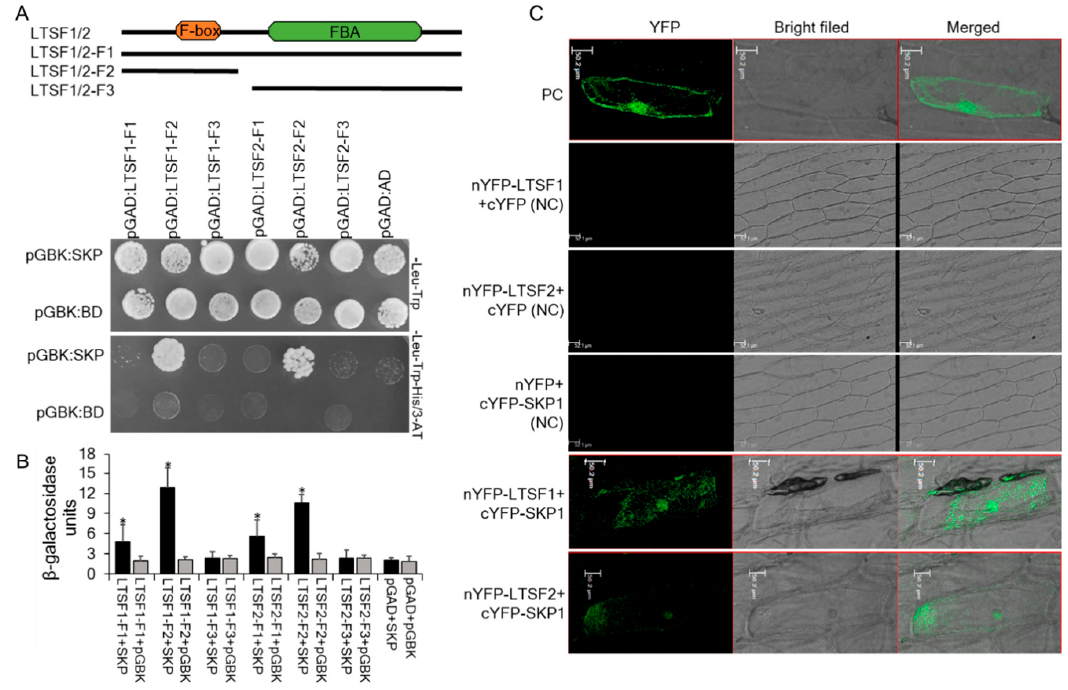
Figure 3. Protein–protein interaction studies involving LTSF1 and LTSF2. ( A ) Yeast two-hybrid assays analyzing the interactions between LTSF1 / 2 and SKP1. The LTSF1, LTSF2, and SKP1 coding sequences were cloned into the pGAD-T7 and pGBK-T7 vectors. Yeast AH109 cells transformed with the designated plasmid combinations were grown on SD/-Leu/-Trp and SD/-Leu/-Trp/-His/+3-aminotriazol (3-AT) media. ( B ) β -galactosidase (GUS) activity assay. Error bars indicate SD of five biological replicates of relative GUS activity assay. The asterisk indicates a significant difference compared with the negative construct ( p < 0.05). ( C ) Bimolecular fluorescence complementation assay of the interactions between pepper LTSF1/2 and SKP1. The LTSF1, LTSF2, and SKP1 coding sequences were cloned into the pSPYCE and pSPYNE vectors. The designated plasmid combinations were co-bombarded into onion epidermal cells for the transient expression of yellow fluorescent protein (YFP), and the fluorescence signals were visualized using a laser-scanning confocal microscope. PC and NC indicate positive and negative